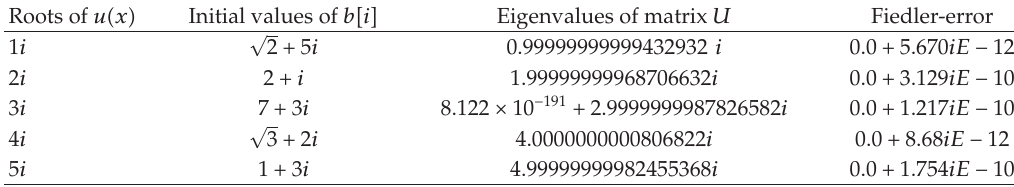
Table 2: Achieved roots of polynomial in Example 5.1 by considering initial values of a complex plane. Roots of u (cid:5) x